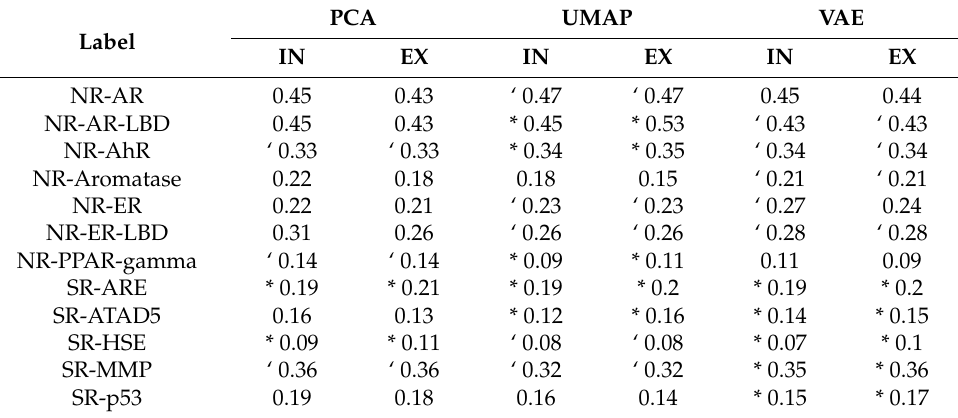
Table 2. Comparison of external and internal embeddings for PCA, UMAP, and VAE. Each cell represents the mean MCC score across nine different machine learning models (three random states × three classifiers). Values marked with an asterisk (*) highlight cases where, on average, models trained using external knowledge outperformed models trained on internal knowledge. Additionally, results marked with a quotation mark (‘) highlight cases where using external or internal knowledge yielded equal results (when rounded off to two decimal